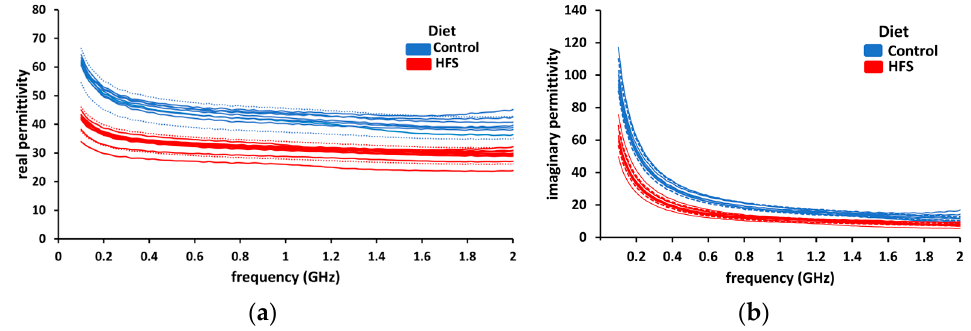
Figure 6. The dielectric permittivity of liver samples. ( a ) The real part of permittivity (blue line) of control diet liver samples and the real part of permittivity of HFS diet liver samples (red lines). ( b ) The imaginary part of permittivity (blue lines) of AIN diet liver samples and the imaginary part of permittivity of HFS diet liver samples (red lines).